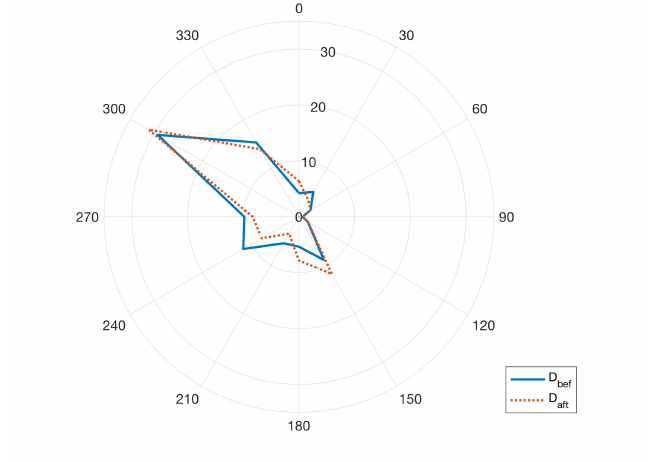
Figure 3. The wind direction rose for Wind Farm 1 during D bef and D aft